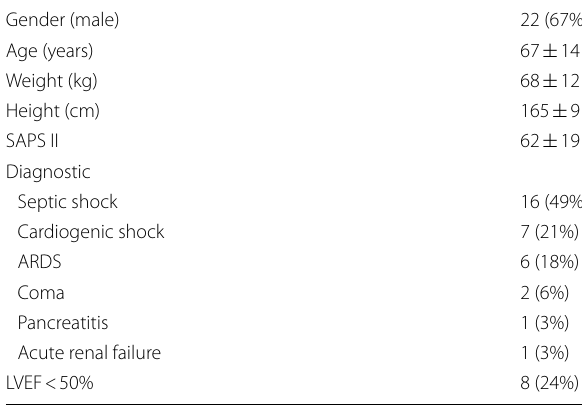
Table 1 Baseline patient